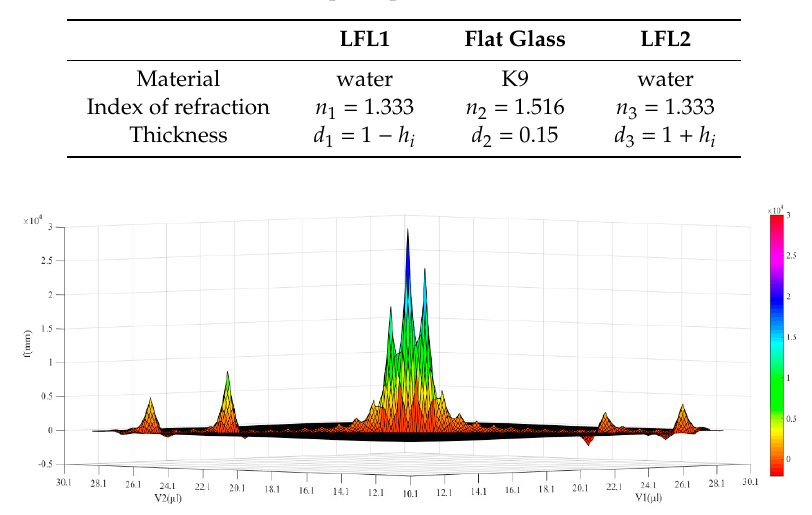
Figure 7. The optical simulation layouts of the UTL with different focal lengths.